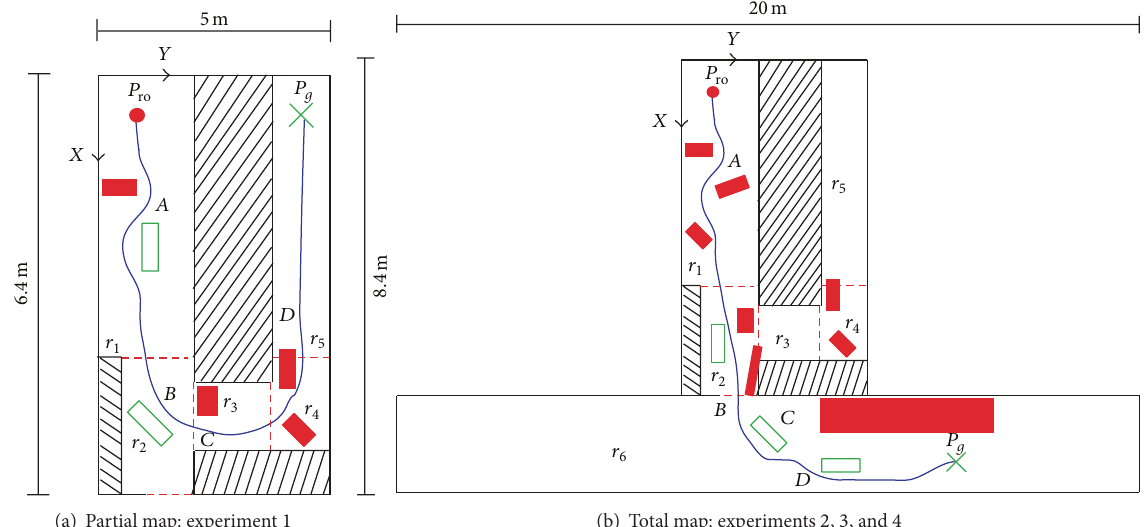
Figure 9: Map of the indoor environment for the field experiments. 𝑟 𝑖 , 𝑖 ∈ {1,...,6} , identify the different regions. Red circle identifies the . Green cross identifies the goal location, 𝑃 𝑔 , where the missions end. Blue line represents the path followed starting position of the robot, 𝑃 ro by the robot. Empty green rectangles represent dynamic obstacles and filled red rectangles represent static obstacles. Striped areas depict forbidden area unreachable by the robot.